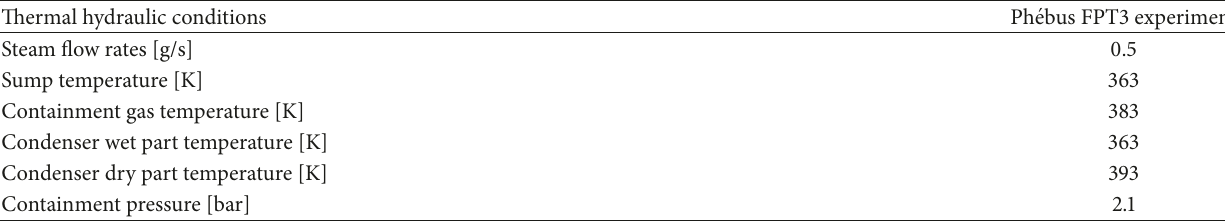
Table 3: Thermal hydraulic conditions of the degradation phase [25].